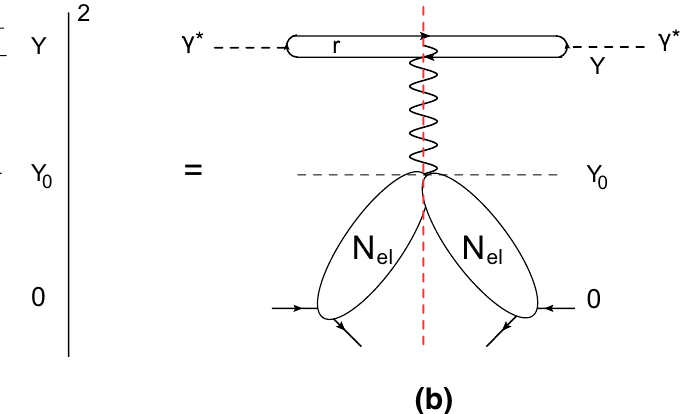
(cid:2) (cid:2) (cid:3) (cid:3) = Q 2 / s where Q is the / s , x Q 2 / Q 2 + M 2 Q 2 + M 2 , x IP = bj X X photon virtuality, s the squared of energy and M X is the produced mass. r ≡ x